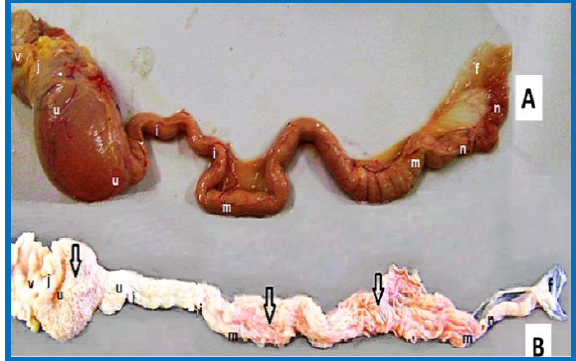
Figure, 5: Gross appearance of laying oviduct (24 weeksMallard duck) shows: A. The funnel (f), neck (n), magnum (m), isthmus (i), uterus (u), junction region (j), vagina (v), mucosal folds (arrows). B. The internal surface of the oviduct with longitudinally oriented mucosal folds